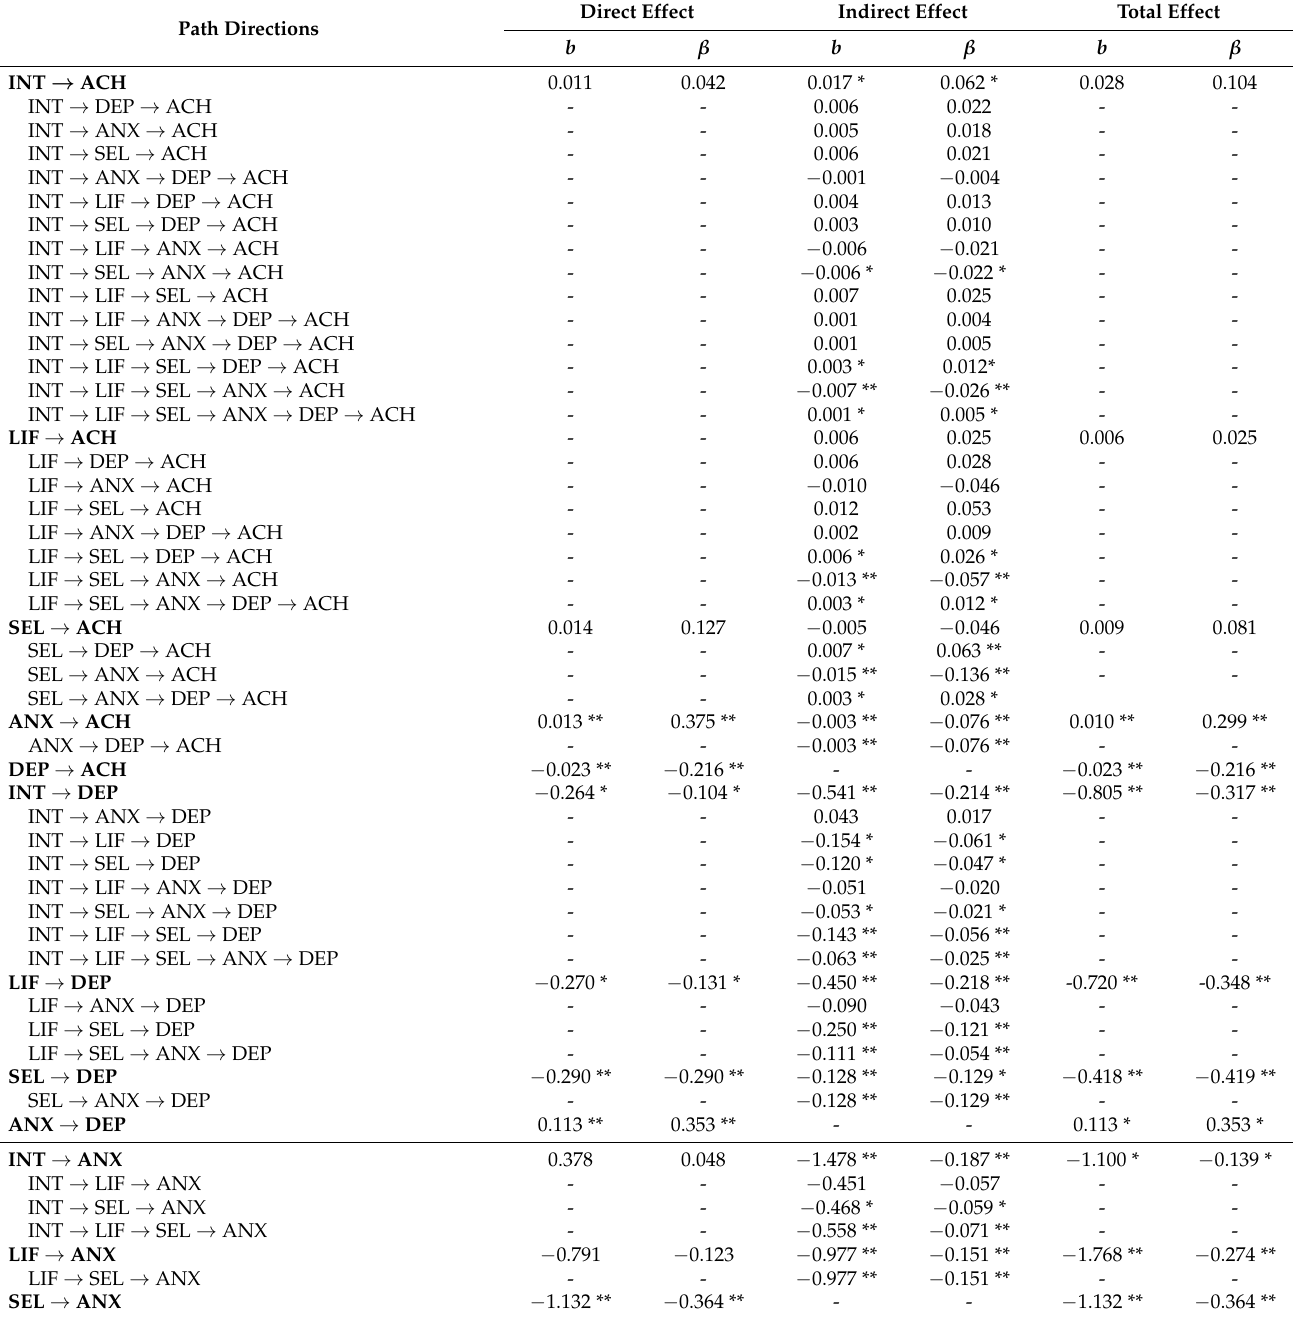
Table 4. Regression coefficients of factors associated with achievement, depression, and